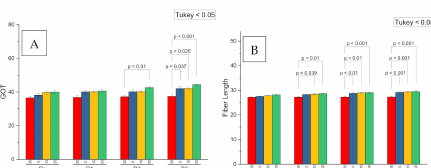
Figure 5. Probability values comparison for the seed dressed (D0 = 0, D1 = 100, D2 = 150 and D3 = 200 mL kg − 1 ) and the soil applied potassium humate on the ginning out turn ( A ) and fiber length ( B ) of cotton.